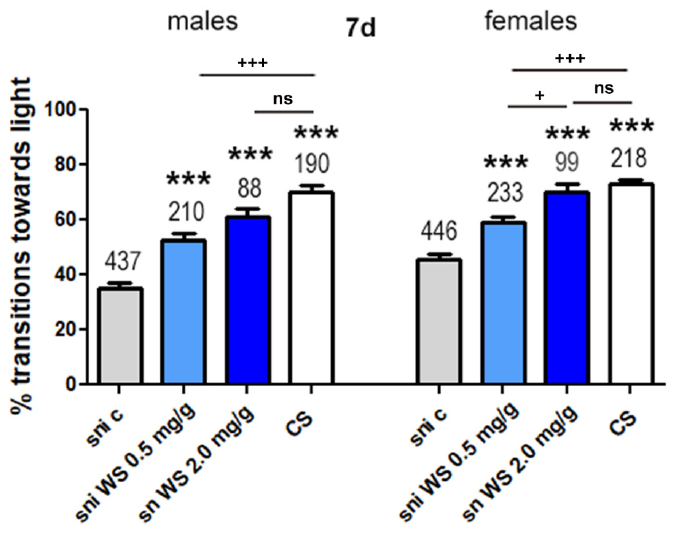
Figure 6. Percentage transitions towards light for sniffer (sni) flies treated with Withania somnifera water extract (WS; 0.5 mg/g and 2 mg/g). Drosophila melanogaster sniffer mutants were fed standard food (c) or standard food supplemented with WS (0.5 mg/g or 2 mg/g) for 7 days. Fast phototaxis was performed with flies in groups of 10–20 flies and separated by experimental group and sex. The number of flies tested is indicated above the bars. Error bars represent SEM. *** = p < 0.001 compared to sni control, + = p < 0.05, +++ = p < 0.001 comparing the two indicated bars. ns = not significant.